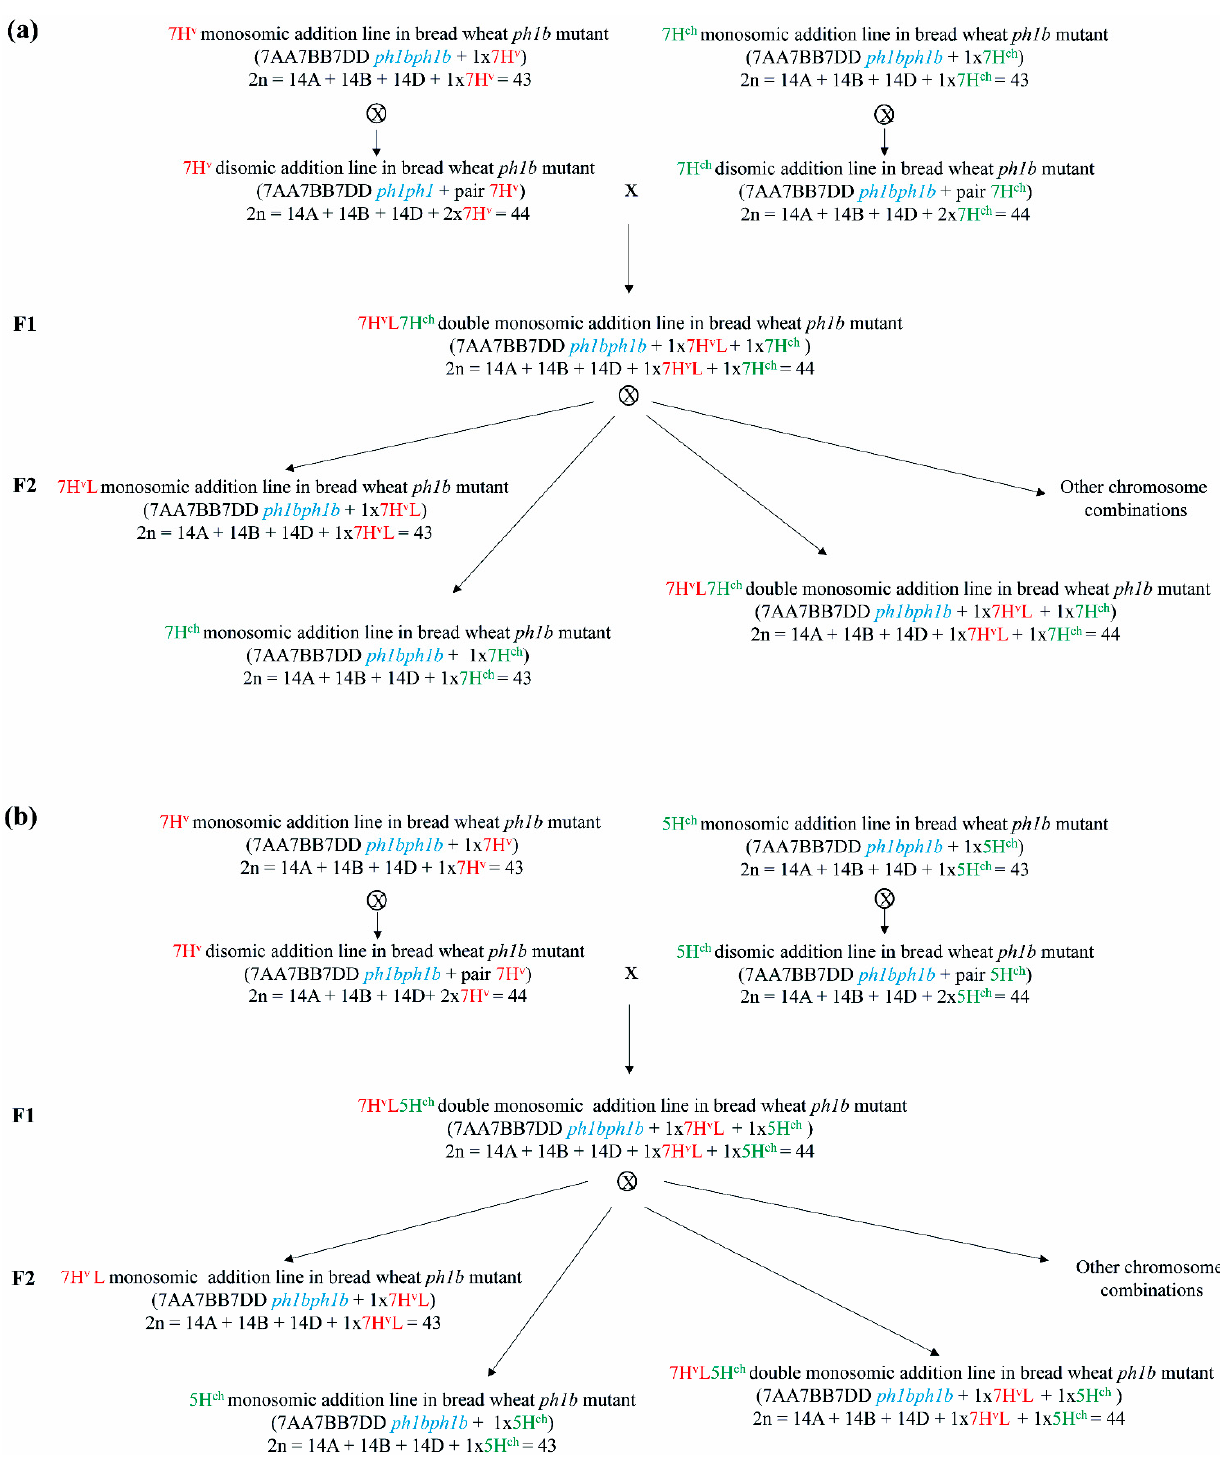
Figure 1. Development of double monosomic H. vulgare and H. chilense addition lines in wheat in the ph1b mutant background. ( a ) Diagram of genetic crosses developed to obtain the 7H v L7H ch double monosomic addition line in wheat in the ph1b mutant background. ( b ) Diagram of genetic crosses developed to obtain the 7H v L5H ch double monosomic addition line in wheat in the ph1b mutant background.